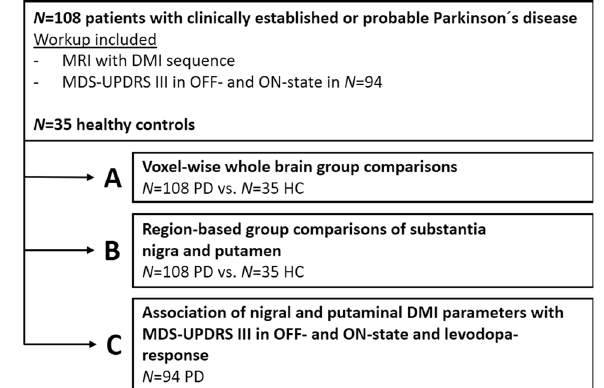
Fig. 5 Study protocol and allocation of participants. MDS-UPDRS III Movement Disorder Society Uni fi ed Parkinson ’ s Disease Rating Scale-Part 3, PD Parkinson ’ s disease, HC healthy controls, DMI diffusion microstructure